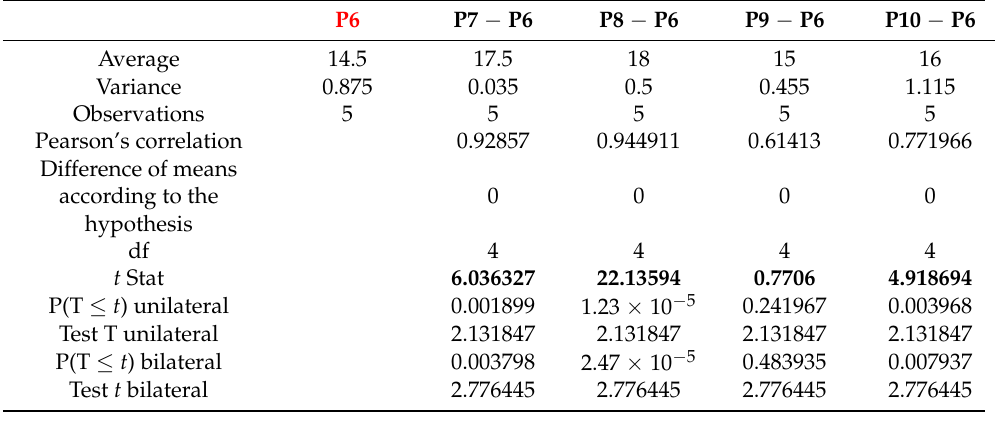
5 of 19 Table 5. Within ‐ subject comparison (comparison of samples to baseline P6) t ‐ test: pairwise pairing for the mean.